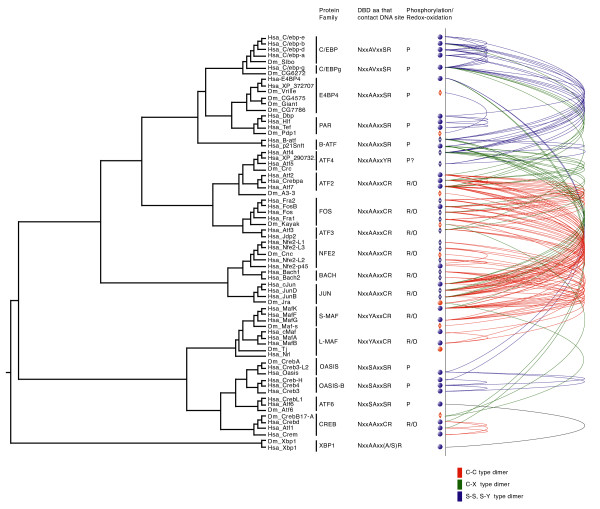
Proportional tree of the human and fruit fly bZIP basic regions. Additional information is added for the five amino acids in the BR that make contact with DNA [5], the presence of a phosphorylation or redox mechanism (depending on the amino acid at position 19) and the dimerizing partners of each protein. Blue circles and diamonds represent human bZIPs, and red circles and diamonds represent Drosophila bZIPs for which interaction data are available. Circles represent proteins that can homodimerize, while diamonds represent proteins that cannot homodimerize. The arcs to the right that connect them represent heterodimerization. The colours of the arcs represent the type of heterodimer formed (red, C-C; green, C-X; blue, S-S and S-Y).